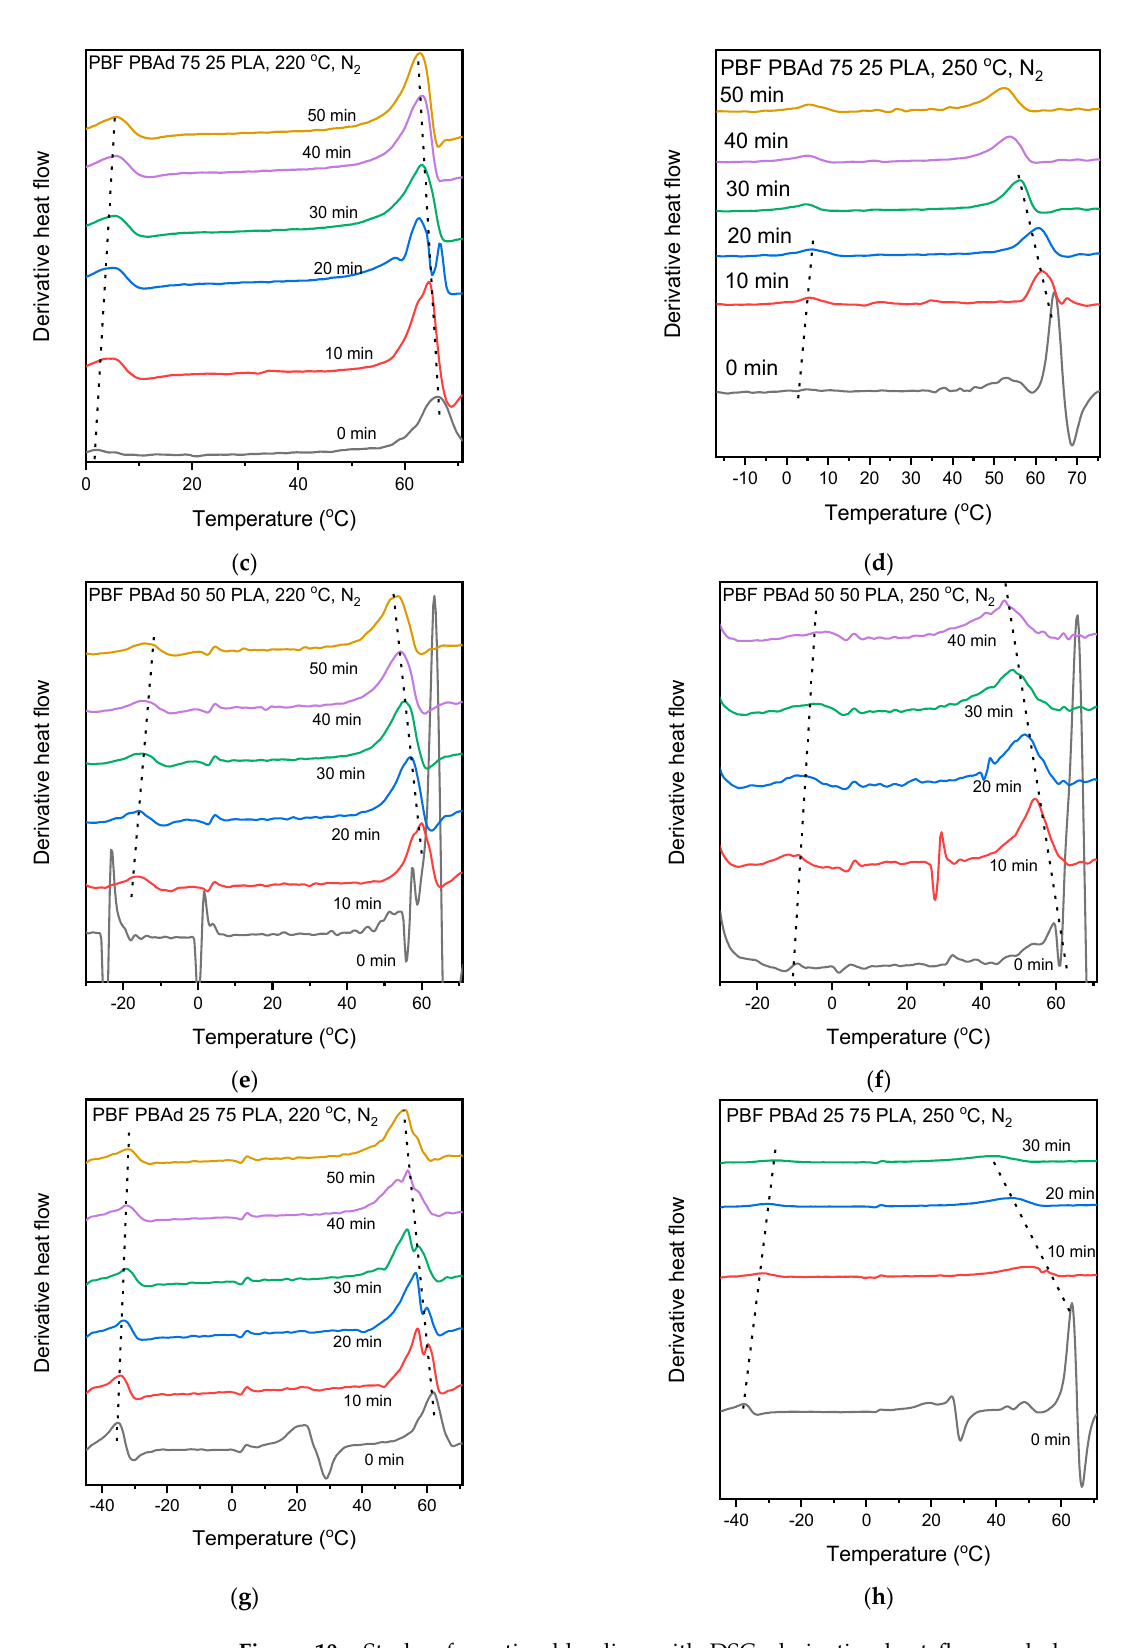
Figure 10. Study of reactive blending with DSC: derivative heat flow and change in the T g of the ( a , b ) PBF PLA, ( c , d ) PBF-PBAd 75 25 PLA, ( e , f ) PBF-PBAd 50 50 PLA and ( g , h ) PBF- PBAd 25 75 PLA